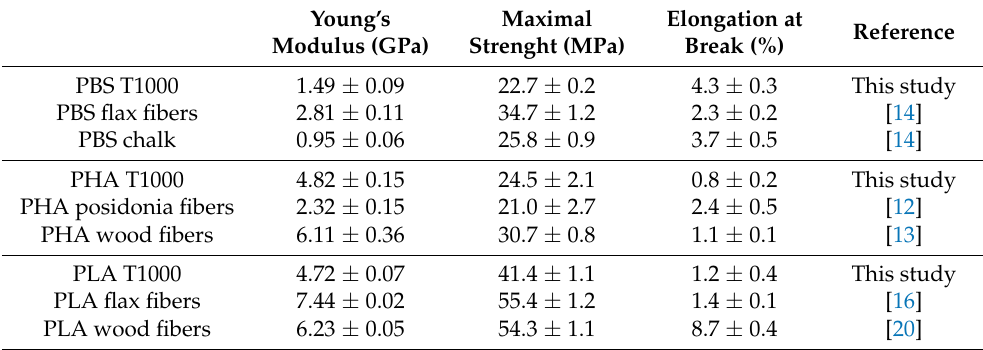
Table 3. Comparison of the mechanical properties of plant fiber composites of this study with literature values. We selected materials processed by compounding and injection molding and having the same fiber weight fraction